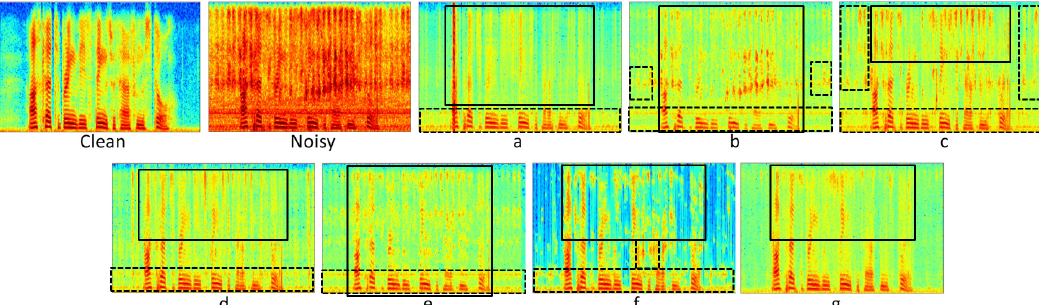
Figure 5. The spectrograms of clean speech, its noisy version with toothbrush noise, and the output estimated clean speech from the seven DNNs. Solid black and dashed lines highlight high distortion and high intensity residual noise,